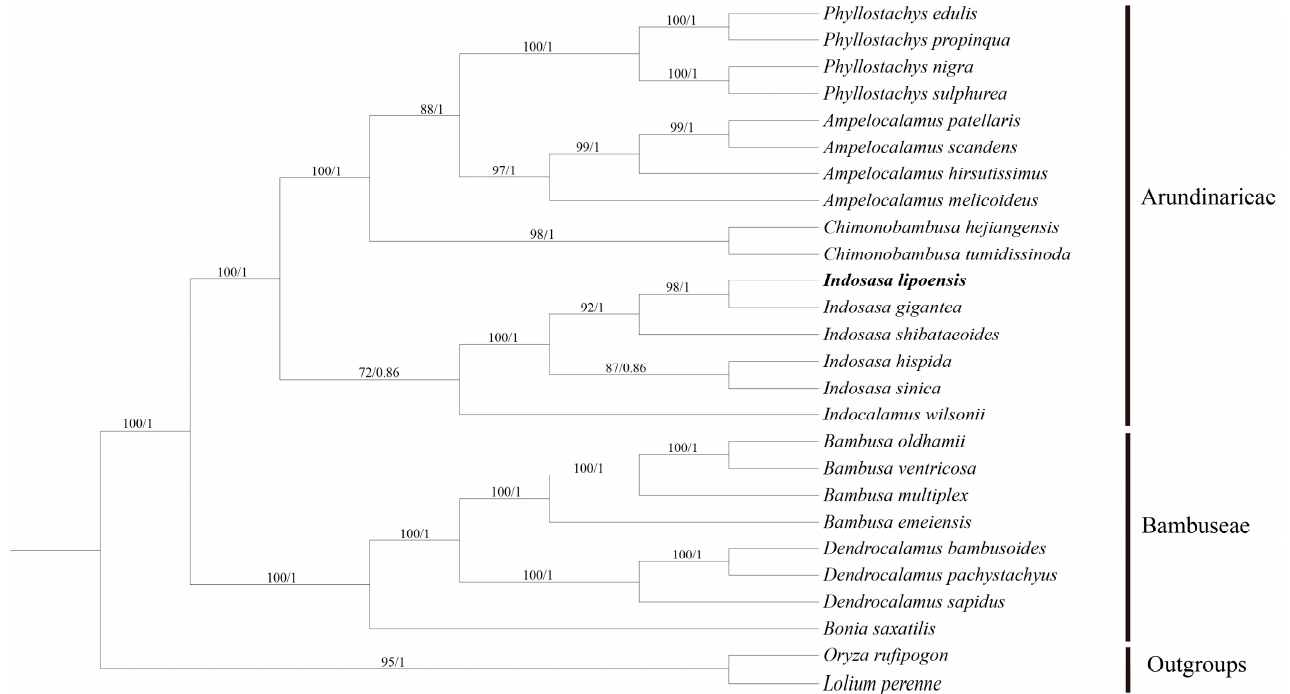
Figure 7. Sliding window analysis of the Indosasa genus entire cp genome sequences.